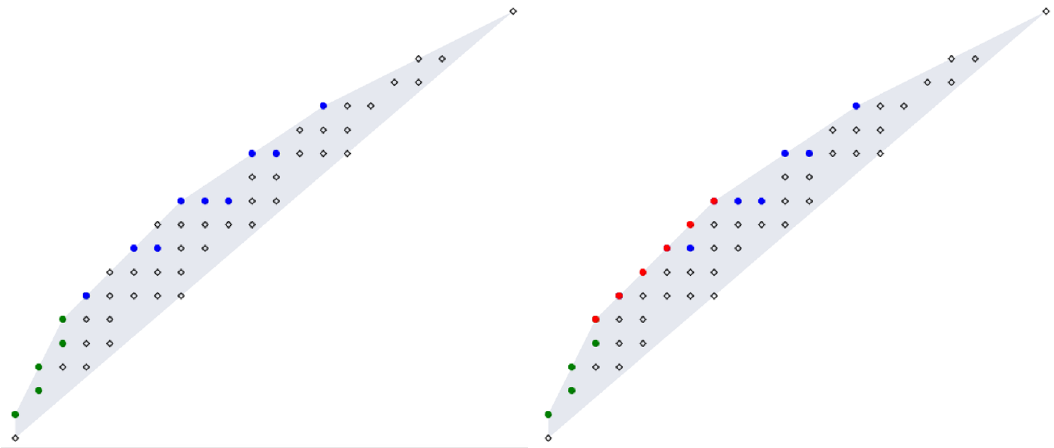
Figure 23 . Newton polygon for diag(2 ; 3 ; 3) quiver: without and with init r 0 .